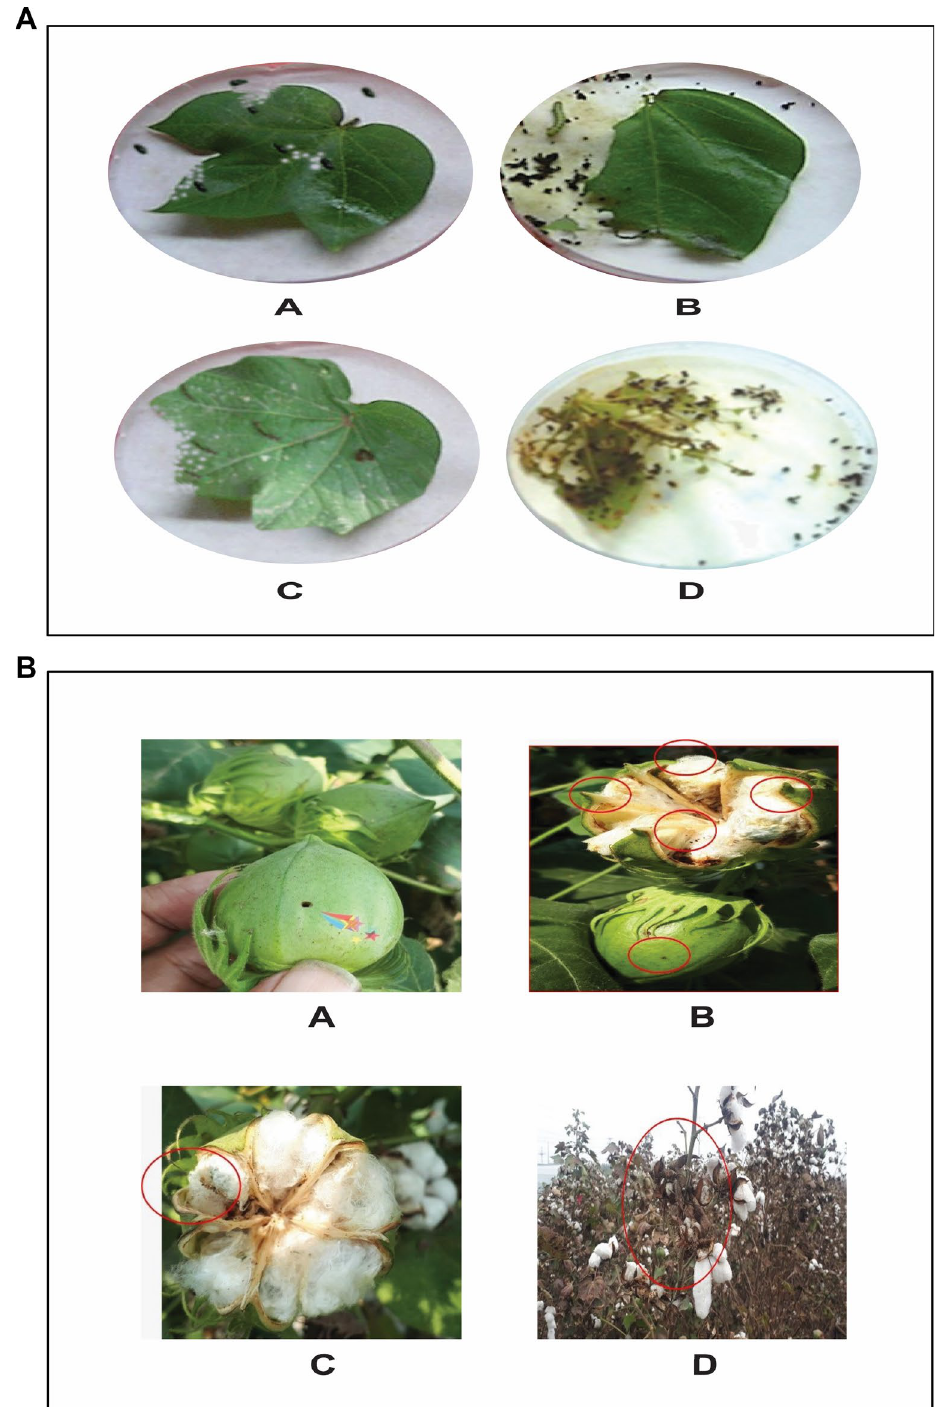
Figure 7. ( A ) Cotton leaf mortality assay of army bollworm in different transgenic and non-transgenic cotton plants. Non-transgenic cotton plant leaf almost completely infected by army bollworm. ( A ) Transgenic cotton plant leaves containing both Bt-gene ( cry3Bb1 and cry3 ), ( B ) shows transgenic plants containing cry3Bb1 , ( C ) shows transgenic plants containing cry3 , and ( D ) shows non-transgenic plants. ( B ) Pink bollworm mortality assay in transgenic and non-transgenic cotton plants. Non-transgenic cotton plant leaf almost completely infected by pink bollworm. ( A ) Transgenic cotton plant leaves containing both Bt-gene ( cry3Bb1 and cry3 ), ( B ) shows transgenic plants containing cry3Bb1 , ( C ) shows transgenic plants containing cry3 , and ( D ) shows non- transgenic